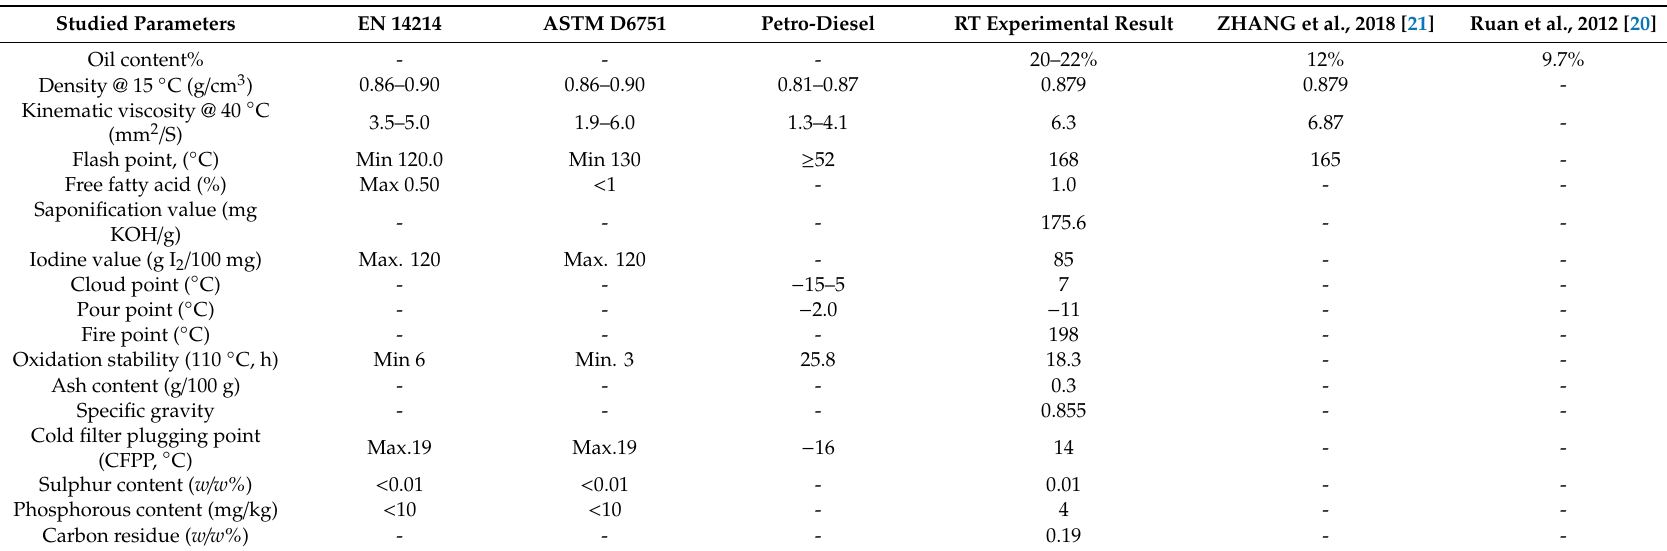
Table 3. Physiochemical characterizations of R. typhina seed oil